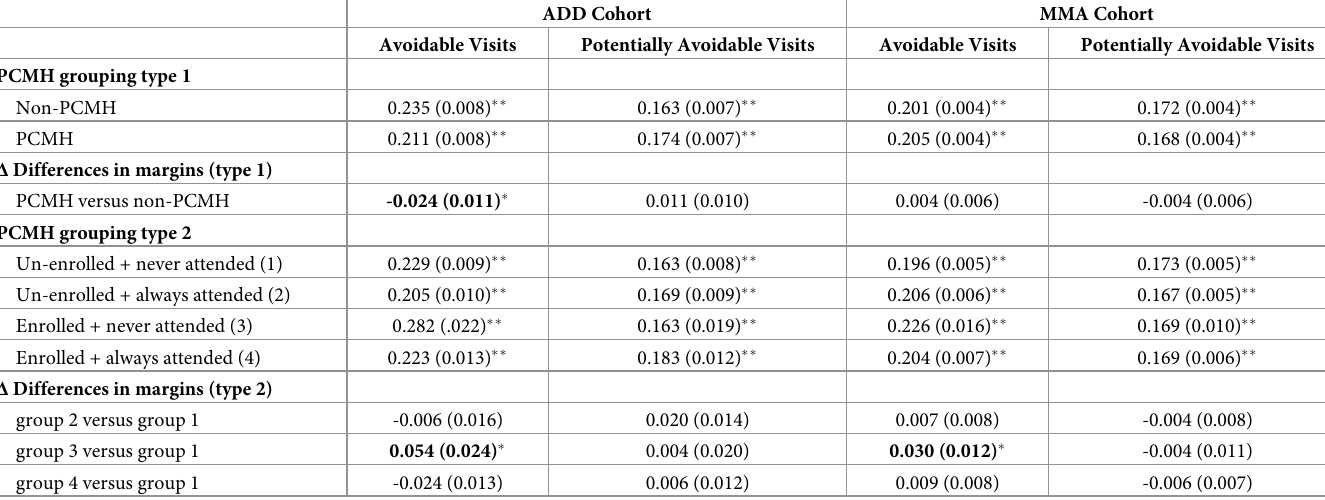
Table 3. A-spatial comparisons of predicted probabilities in ED visit category by medical home attribution grouping